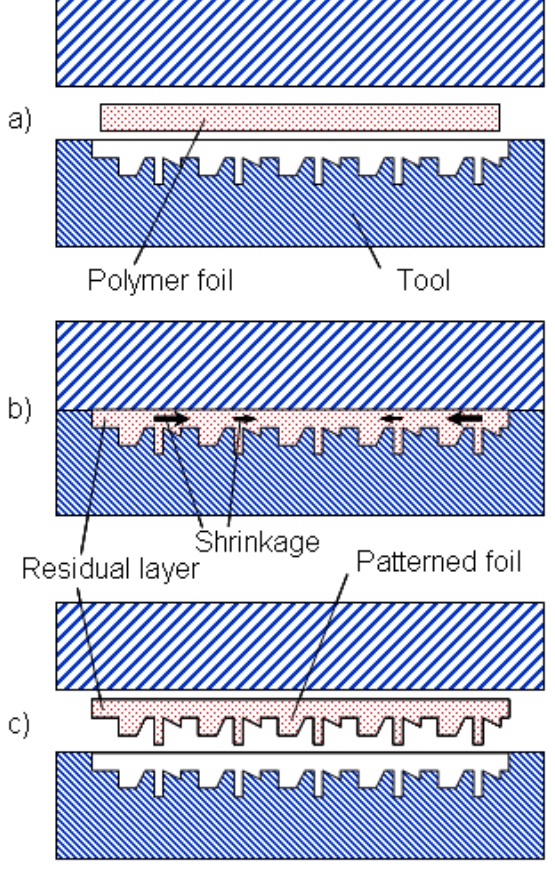
Figure 1. Schematic drawing of hot embossing: (a) Inserting a polymer foil into the heated tool; (b) Closing the tool and cooling down; (c)